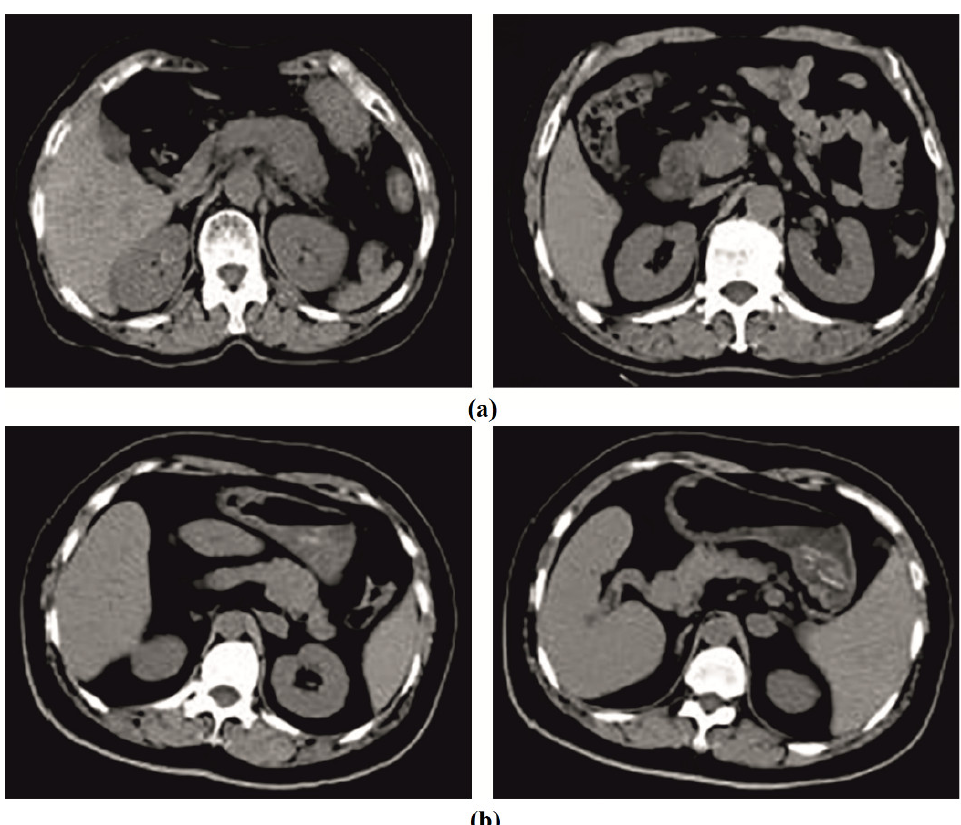
Figure 2. Sample images: ( a ) tumor; ( b ) non-tumor.